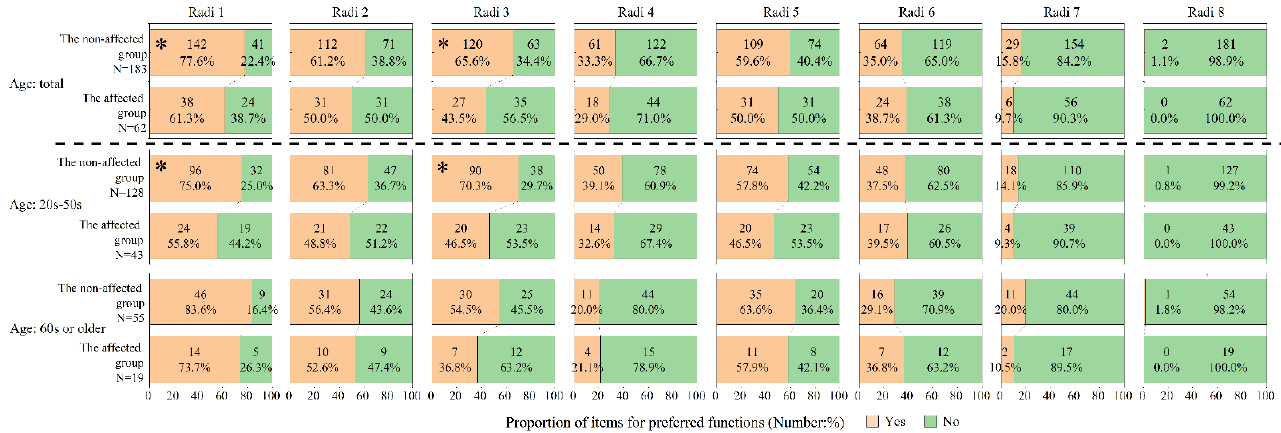
Figure 2. Preferred functions of radiation-related devices and applications. a . a Subjects interested in radiation-related devices and applications were asked to select functions that they preferred. Preferences of application function were as follows: Radi (1) Measure environmental radiation level, Radi (2) Measure radiation level in food and other consumable products, Radi (3) Provide real-time information on the current situation (official channels only), Radi (4) Provide real-time information on the current situation (non-government channels), Radi (5) Provide general information on the effect of radiation on health and protection measures, Radi (6) Provide specific instructions related to my personal situation and status, Radi (7) Provide some degree of interactivity (questions/answers/live chat), and Radi (8) Others. Asterisk (*) indicates p < 0.05.